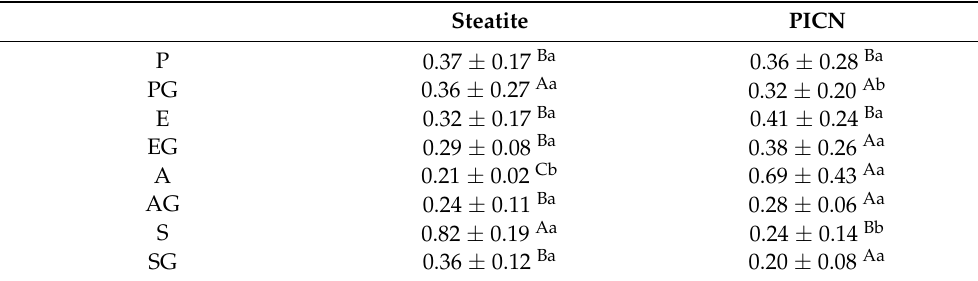
Figure 3. Line graphs showing the spacing roughness (Rsm) of each experimental group at the established intervals. Table 4. Means and standard deviations of average roughness ( µ m) of each experimental group at the end of the physiological wear